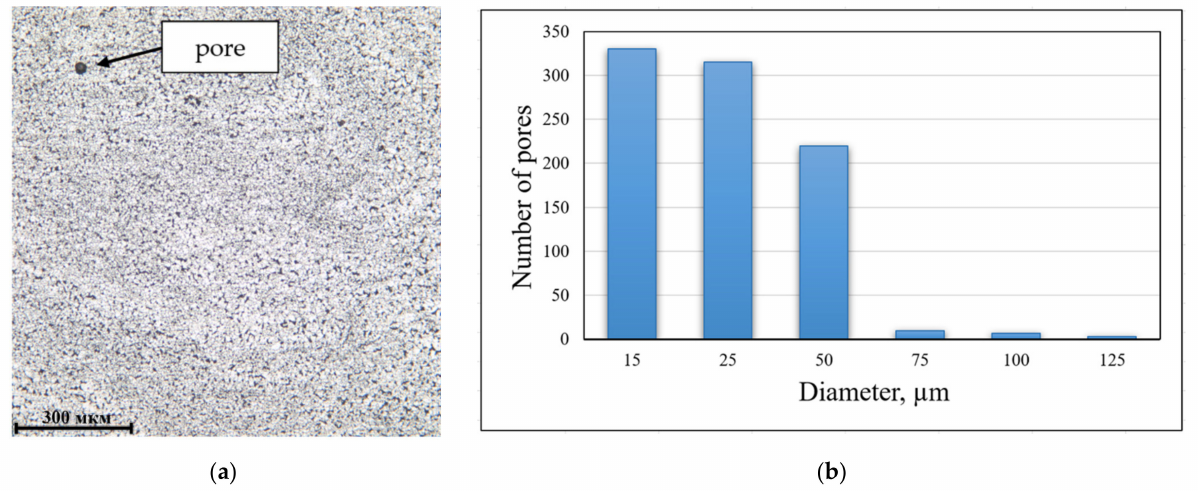
Figure 8. ( a ) Microstructure of specimens aged at 300 ◦ C/6 h (100 × ); ( b ) cross-sectional pore distribution.